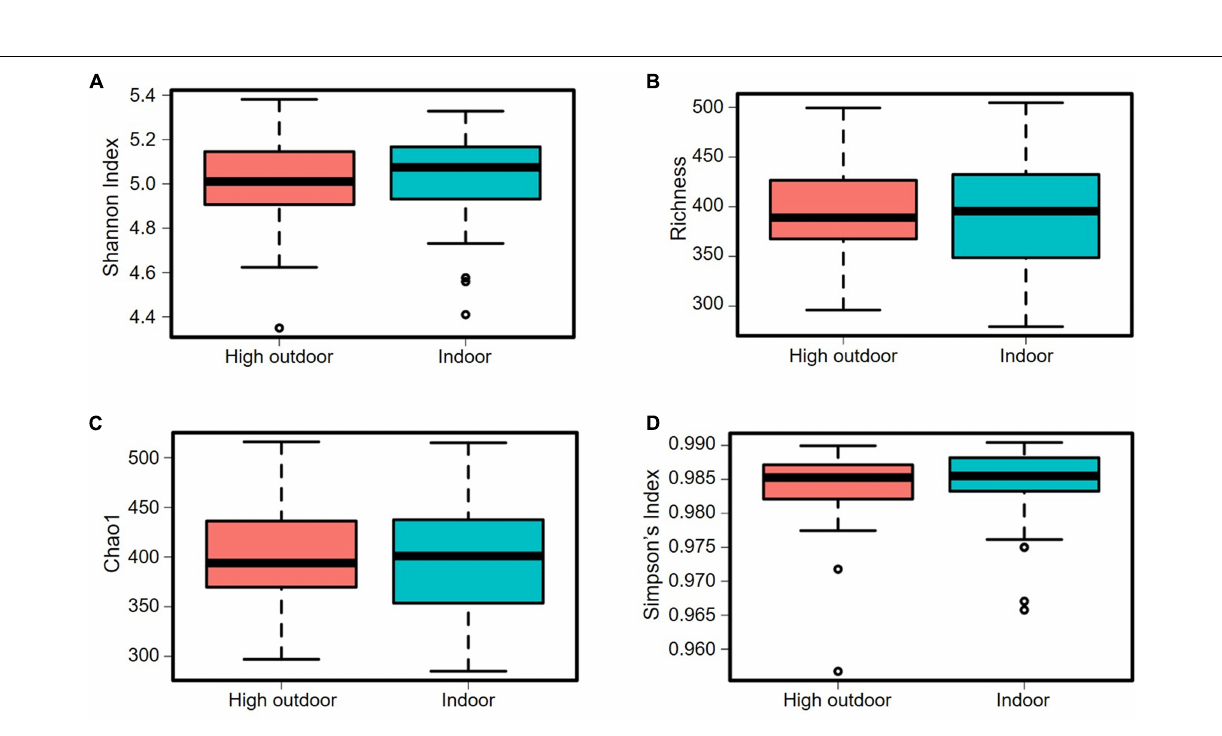
Frontiers in Microbiology |